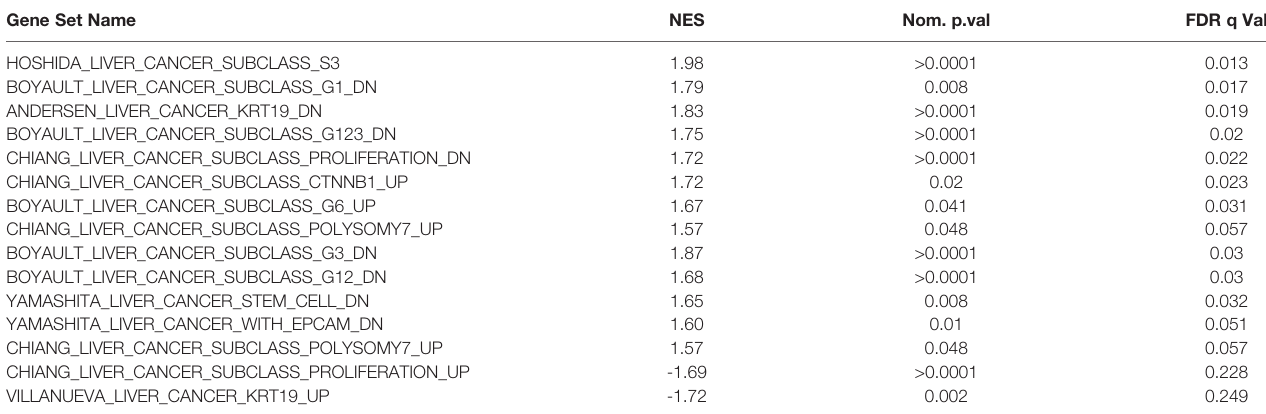
TABLE 3 | Selected enriched genesets according to NAA40 levels relating to molecular classi fi cation of HCC. Gene Set Name NES Nom.